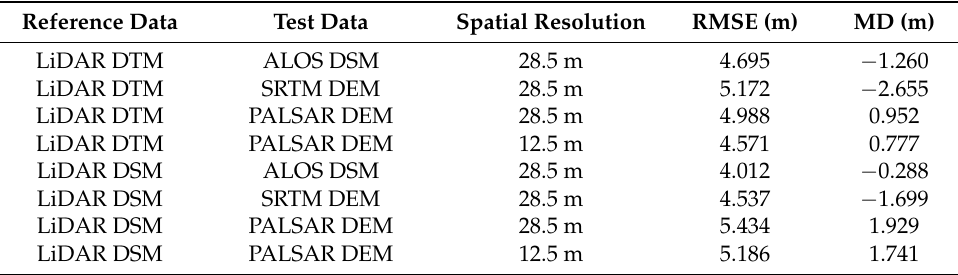
Table 4. Statistical vertical differences between global DEMs and LiDAR DTMs/DSMs expressed in terms of RMSE and MD in m.